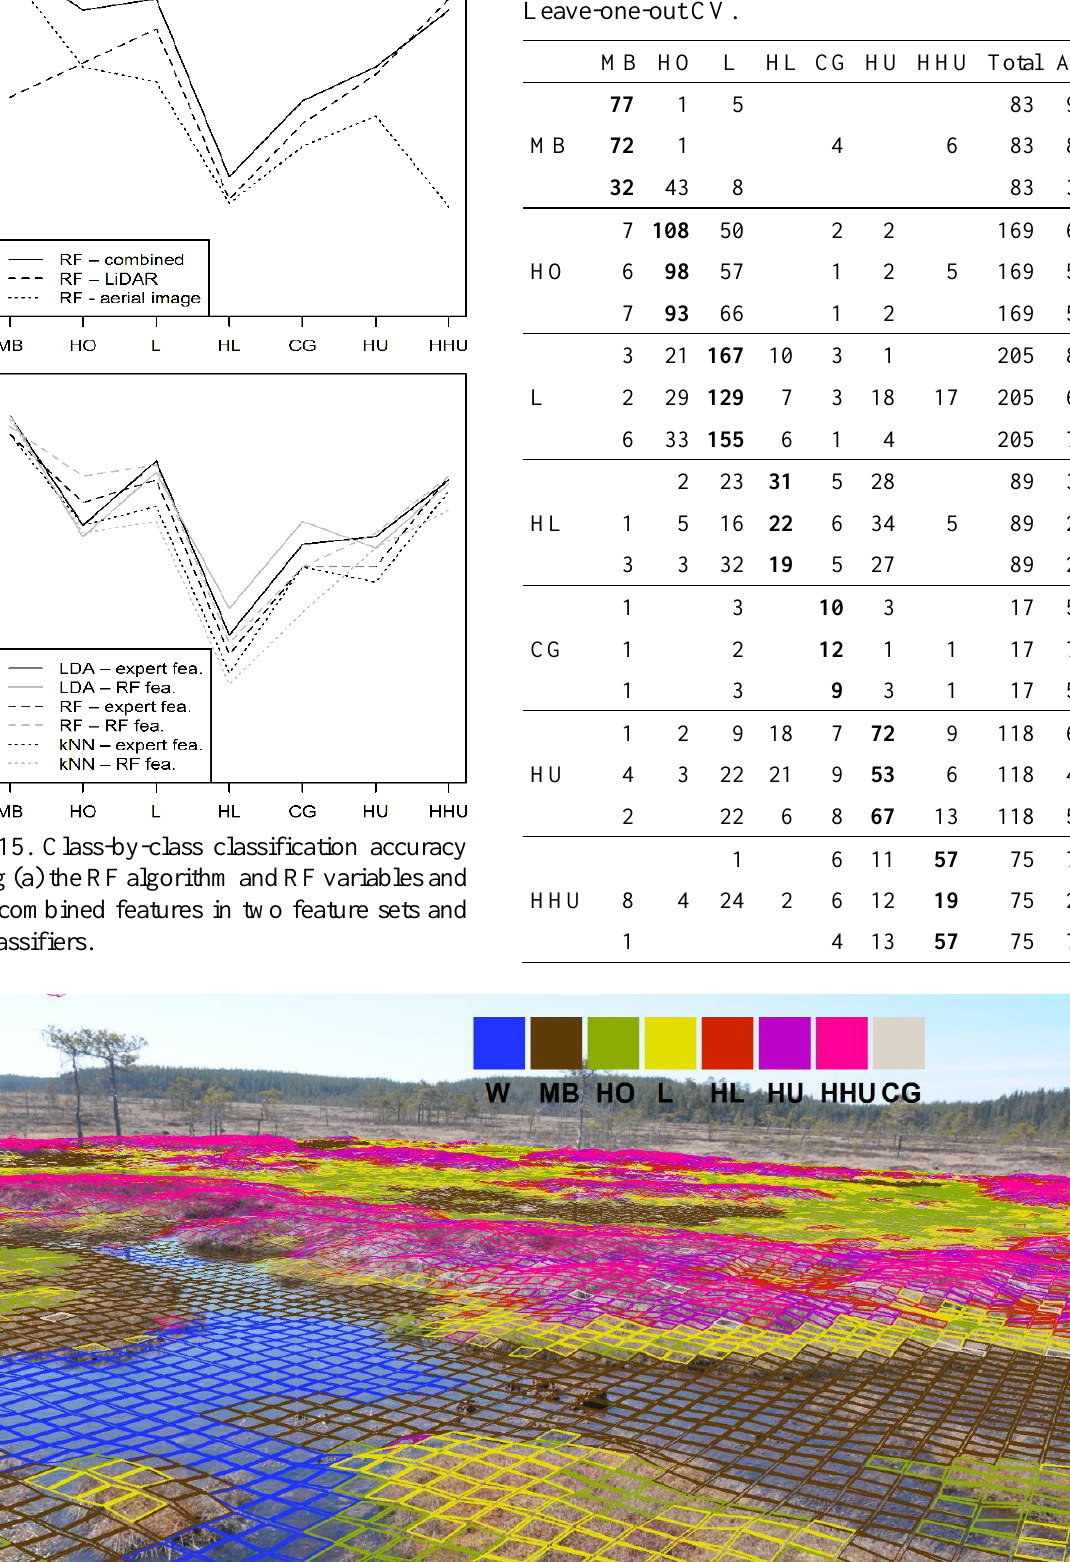
Table 10. Best-case LDA classification performance with the combined (top row), image-based (middle row) and LiDAR-based (bottom row) expert features.